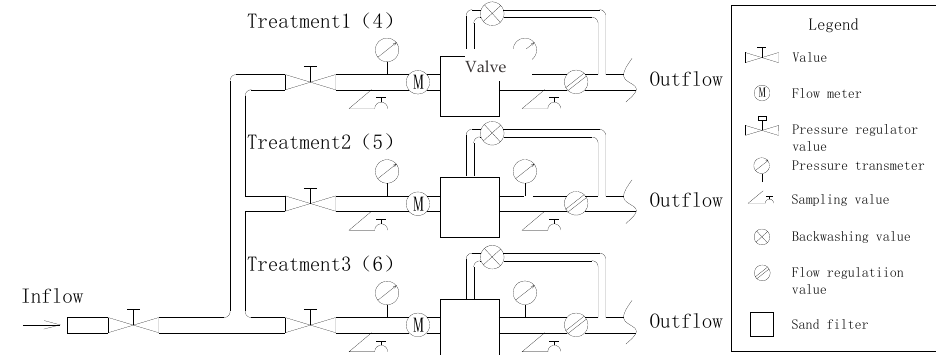
Figure 2. Sand filter pipe network showing the locations of the monitoring equipment. Table 2. Range of variables during testing.